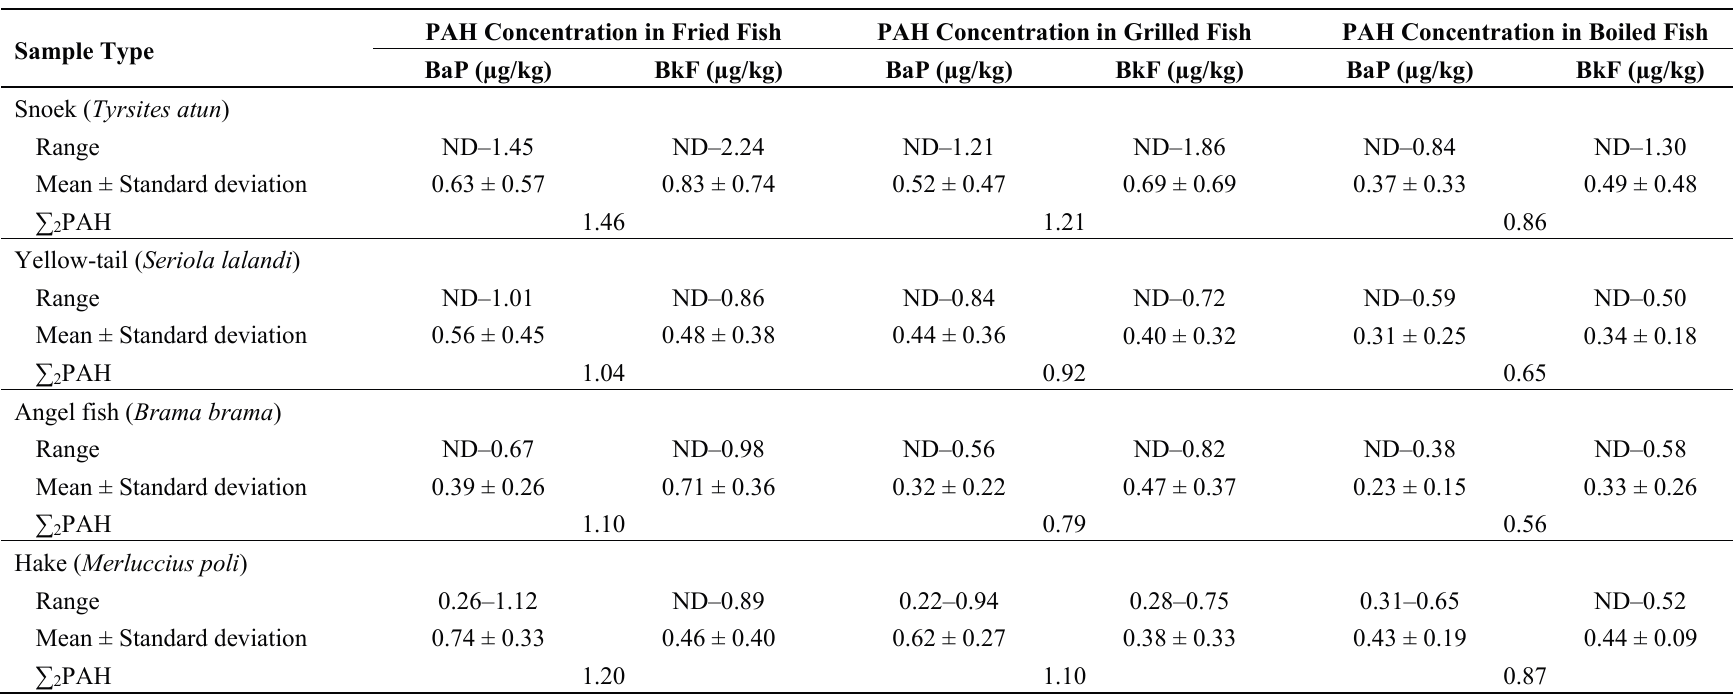
Table 1. Concentration (µg/kg) of BaP and BkF fraction in PAH extracts from the different fish samples processed by different